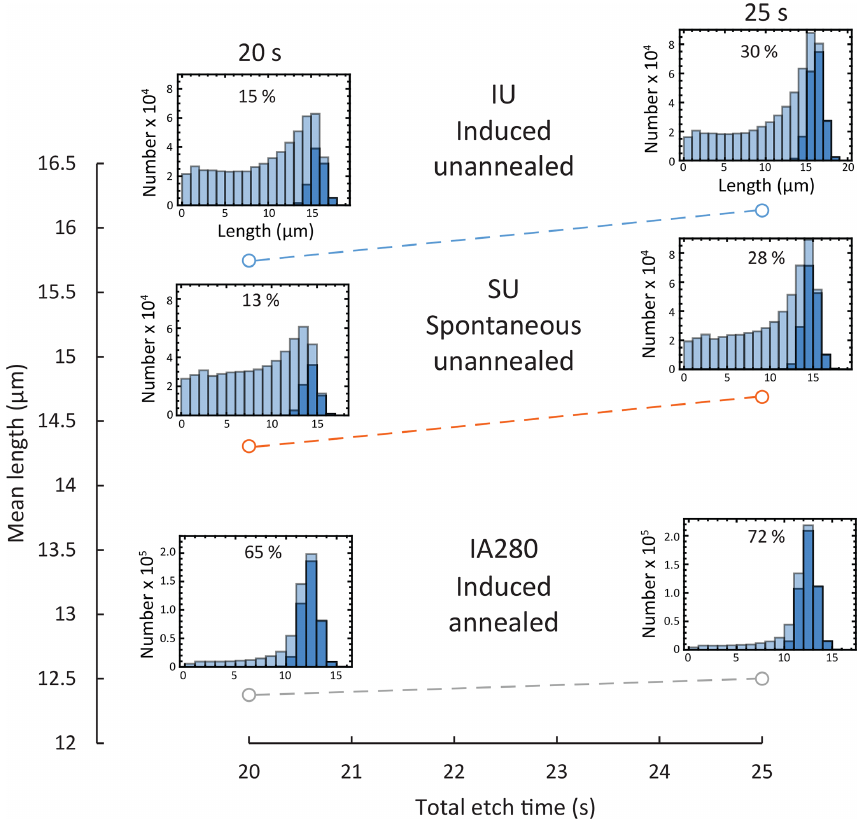
Figure 19. Model predictions of effects of etching for 25 versus 20s for various track types, assuming the selection criterion v T /v B = 12. Histograms show confined (light bars) and selected (dark bars) tracks for each point, and percentages reflect the proportion of confined tracks selected. Note that SU model predictions do not presume Cf irradiation, reducing selection efficiency compared to the results reported